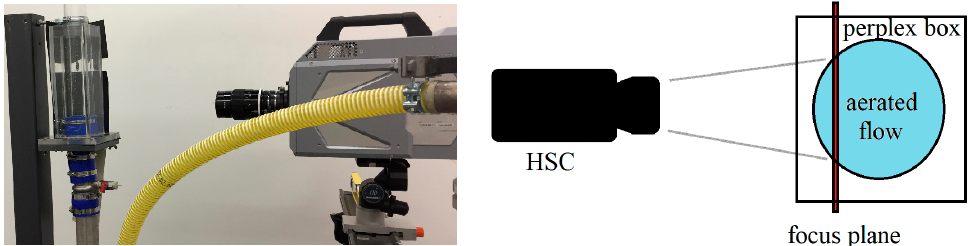
Figure 5. High-speed camera (HSC) set-up ( left ) and schematic illustration of the camera focal plane location in top view ( right ).